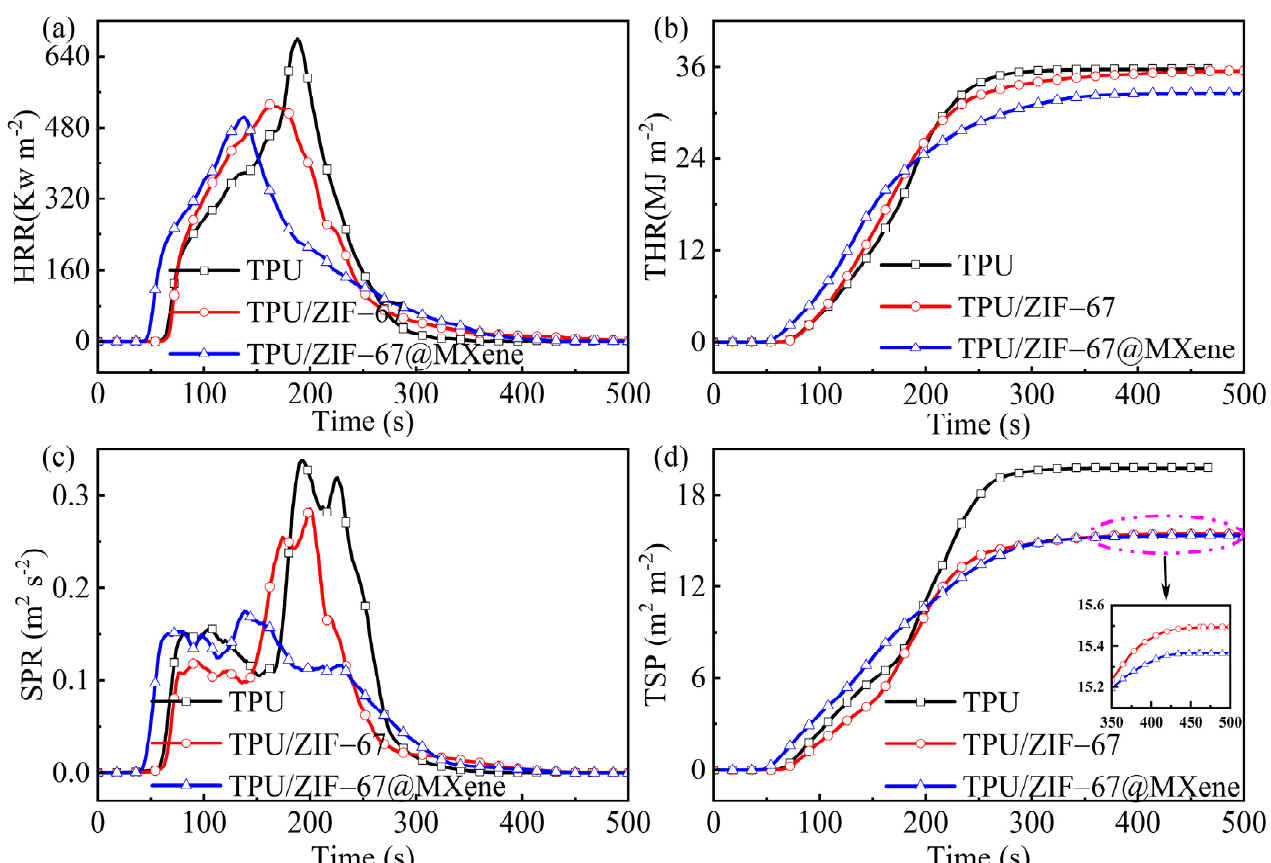
Figure 5. ( a ) HRR, ( b ) THR, ( c ) SPR, and ( d ) TSP yield curves of TPU composites. Figure 5. ( a )HRR, ( b )THR, ( c ) SPR, and ( d ) TSP yield curves of TPU composites. Table 2. CCT data of TPU